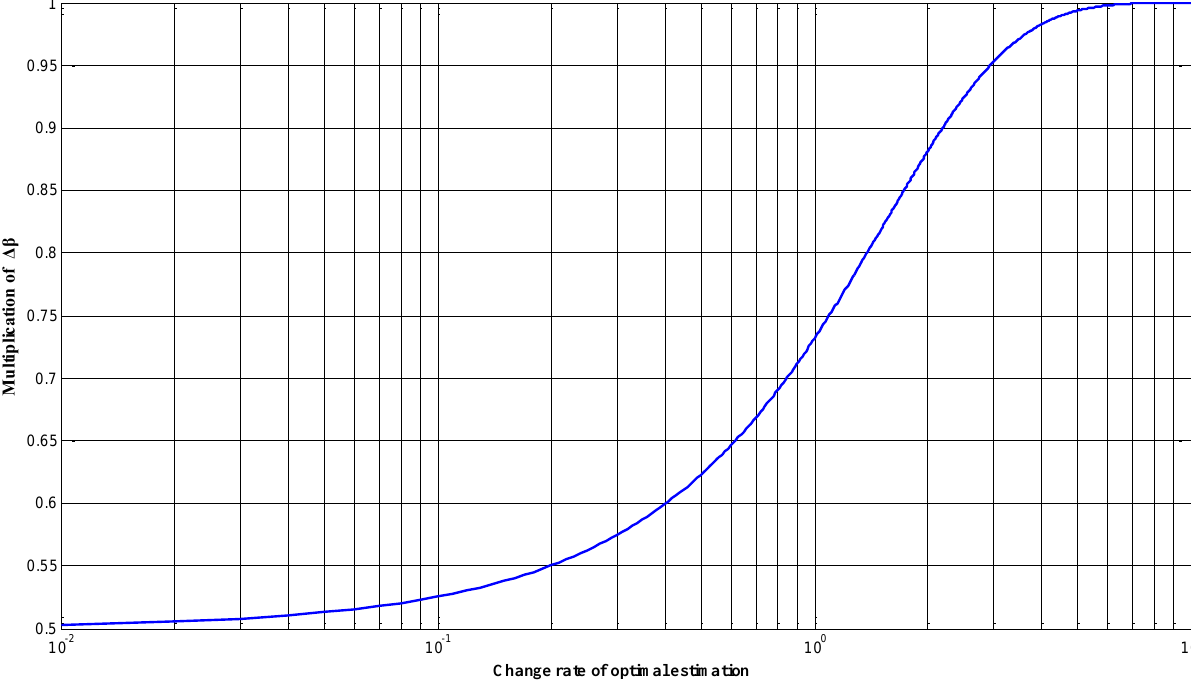
Figure 3. A typical curve of the creative coefficient  as affected by the changing rate of the optimal estimation fit  , where the traverse axis is a logarithmic